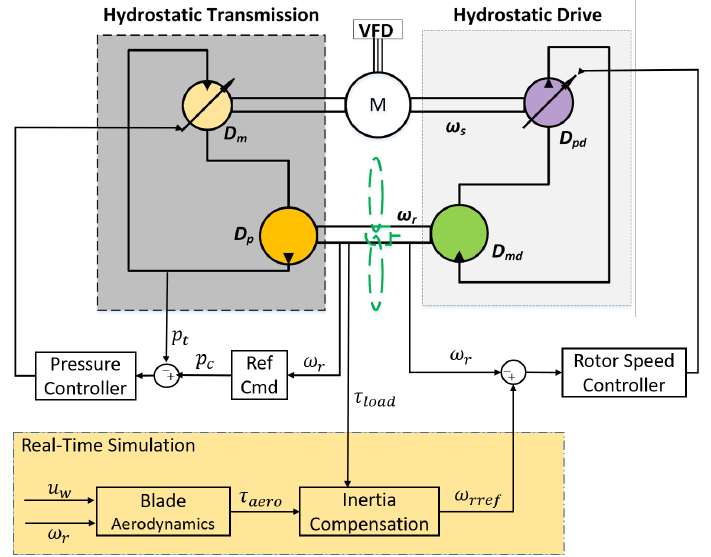
Figure 4. Schematic of the hardware-in-the-loop test on the power regenerative dynamometer.